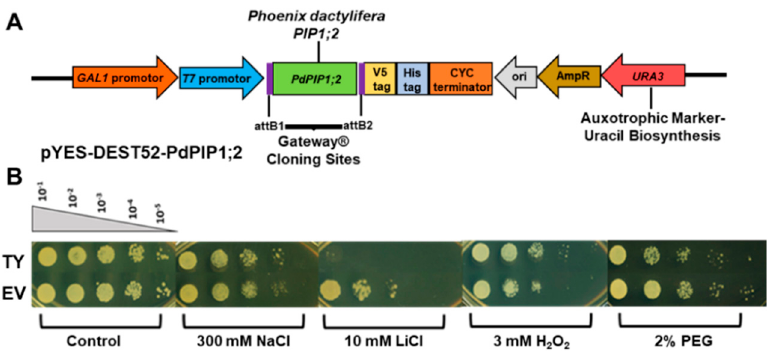
Figure 5. Schematic representation of cloned PdPIP1;2 gene in pYES-DEST52 plasmid for overexpression in yeast ( A ). The effect of PdPIP1;2 transgene on the growth of yeast cells on solid culture. Yeast spot assay used to test the relative tolerance of transformant yeast (TY) and empty vector (EV) cells when grown under control and other different abiotic stress conditions ( B ).